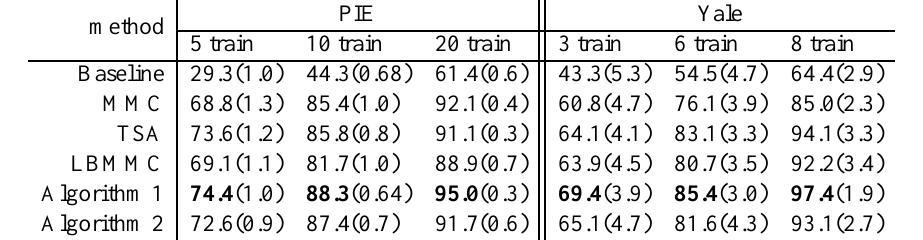
Table 2: The mean value(%) and standard derivations(%) of top recognition rate over 10 random split experi- ments